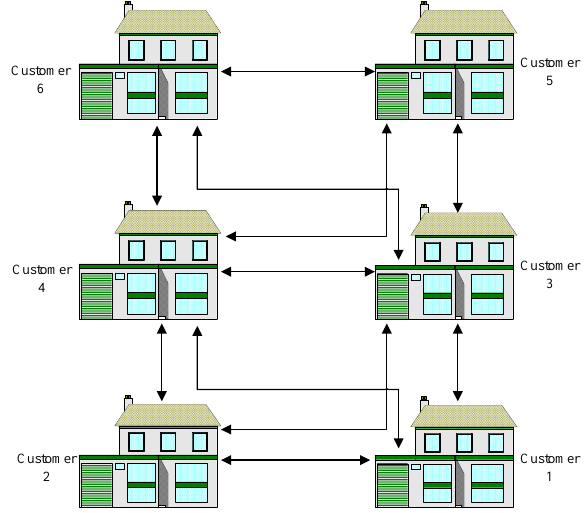
Figure 3. Communication topology of the six-customer system: neighbor interconnection.